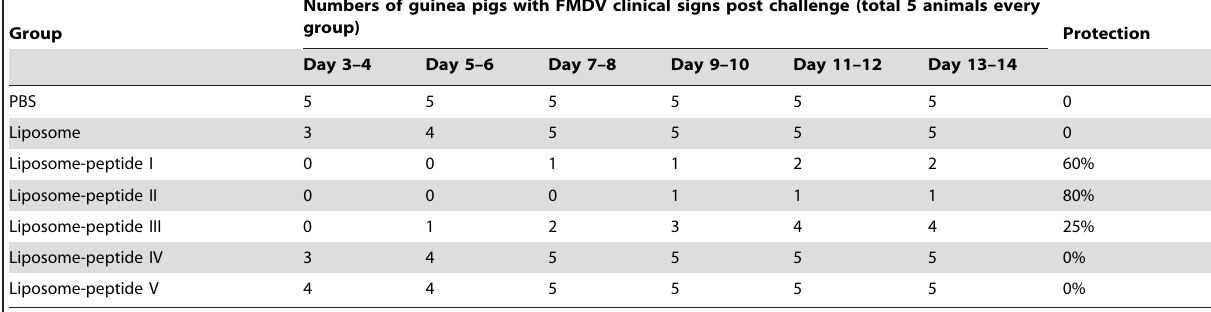
Table 3. Protective efficacy for immunized guinea pigs after FMDV challenge.